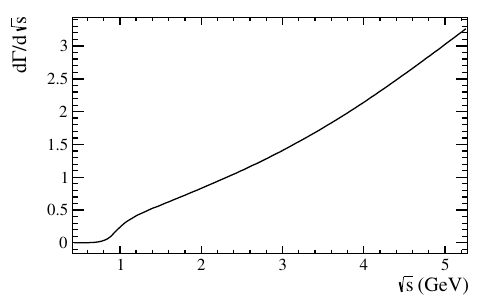
Figure 5 . Energy-dependent width of the a (cid:6)